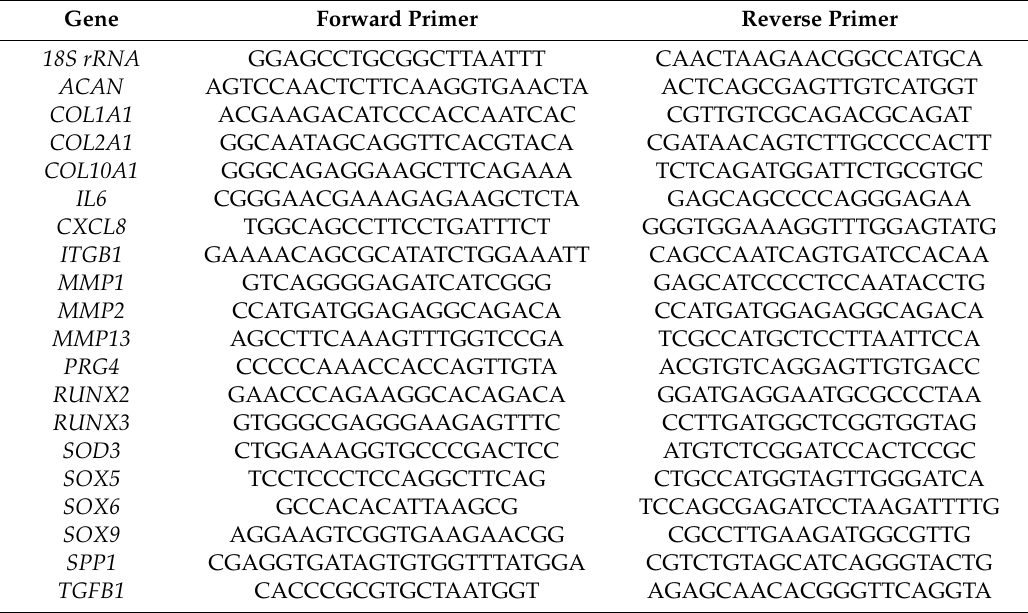
Table 1. List of primers used for qPCR